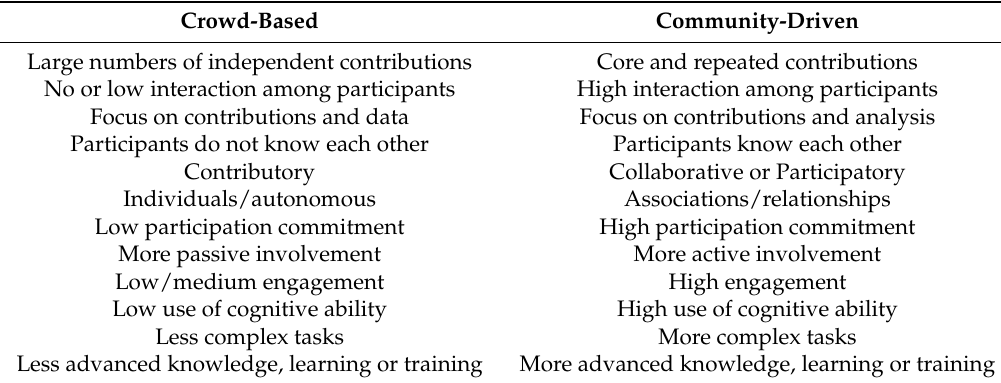
Table 3. Crowd-Based/Community-Driven Online Participation